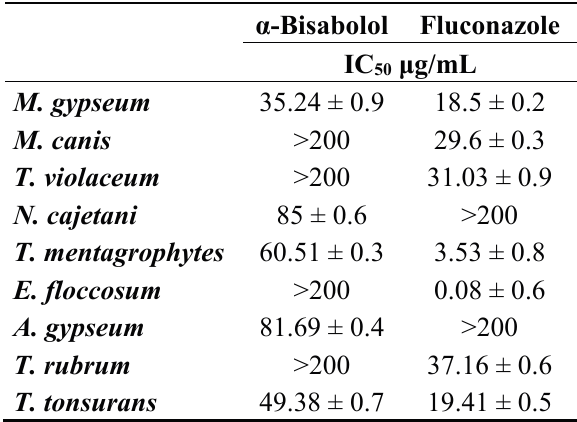
Table 2. IC 50 values of α -bisabolol and Fluconazole on dermatophytes. Each value is the mean of three